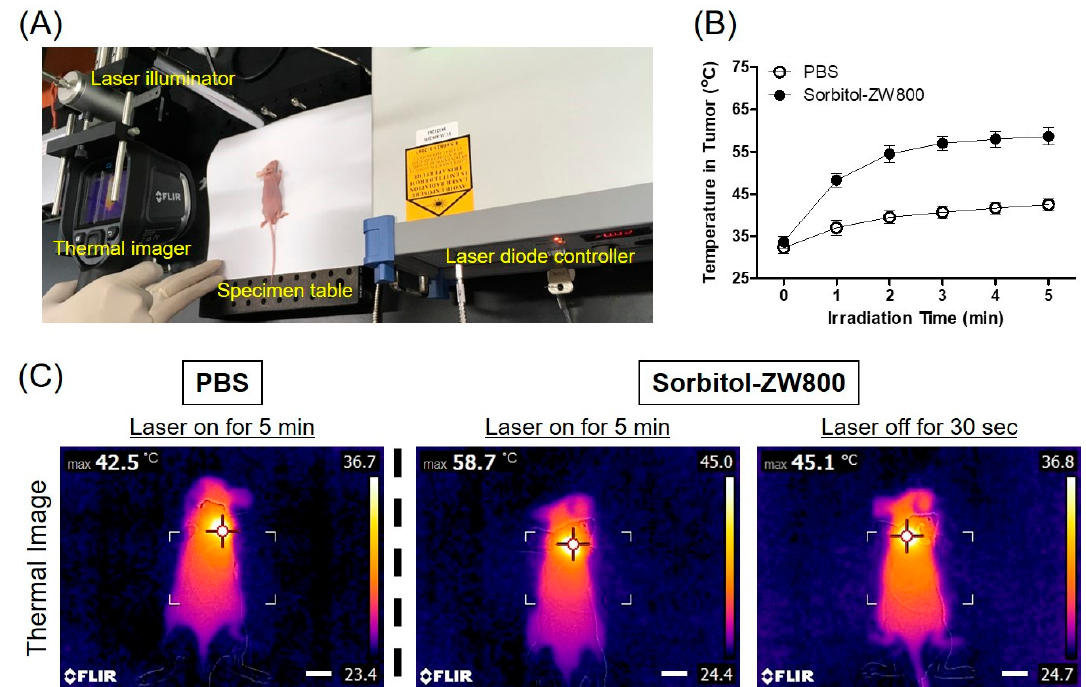
Figure 4. ( A ) A photograph of the photothermal imaging system equipped with a 808 nm laser illuminator, a laser diode controller, and a thermal imager. The 1.1 W / cm 2 laser power density was determined by laser parameters of 5 mm beam diameter and 0.22 W power. ( B ) Temperature changes at the tumor sites in each treatment group were monitored for 5 min of the 808 nm laser irradiation (1.1 W / cm 2 ). Data are expressed as mean ± S.D. of the three independent experiments. ( C ) The whole-body photothermal images of tumor mice at 2 h post-injections of PBS and sorbitol–ZW800 (10 nmol, 0.4 mg / kg), respectively, under exposure to the 808 nm laser irradiation (1.1 W / cm 2 ) for 5 min. The maximum tumor temperatures were automatically recorded with an infrared thermal camera as a function of irradiation time. Scale bars = 1